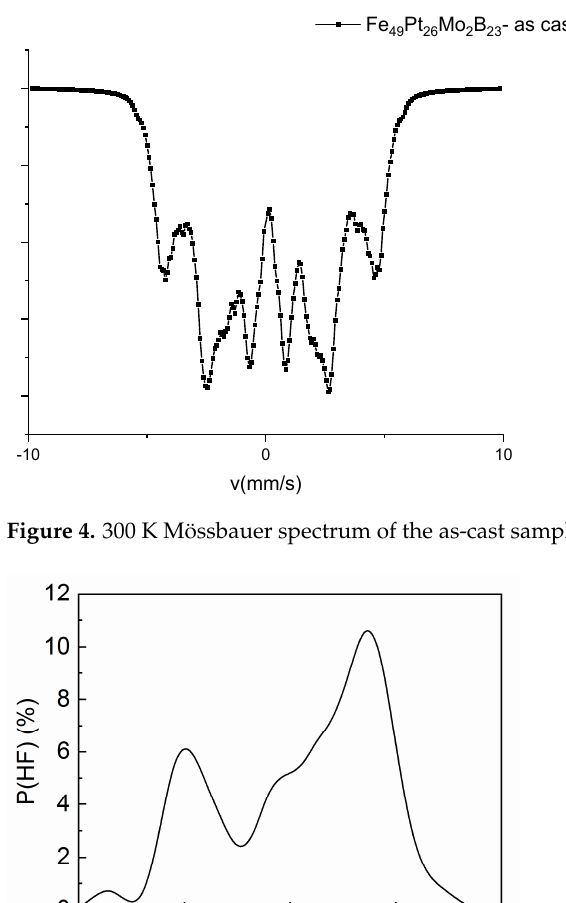
Figure 5. Bimodal hyperfine field distribution, as resulted from fitting of the Mössbauer spectrum in Figure 4.